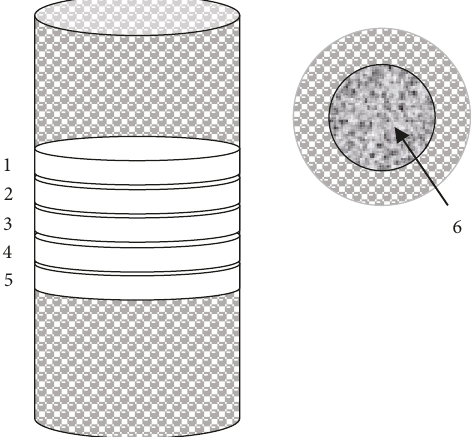
Figure 2: Cutting of the samples. Samples 2 and 4 were for MEB observations, and only part 6 was observed; samples 1, 3, and 5 were for mechanical